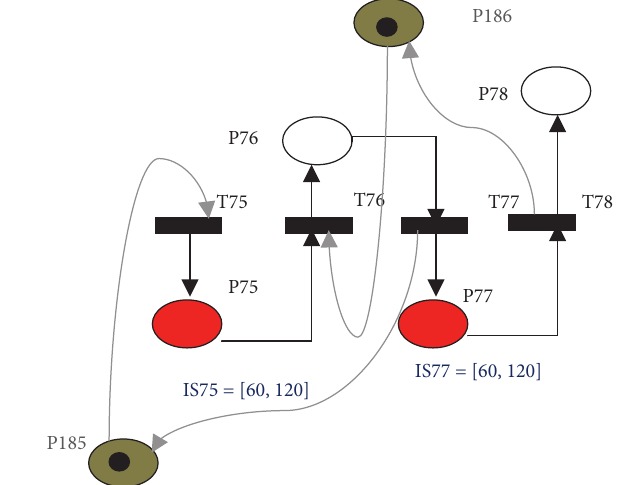
Figure 5: Catch-up places P185 and